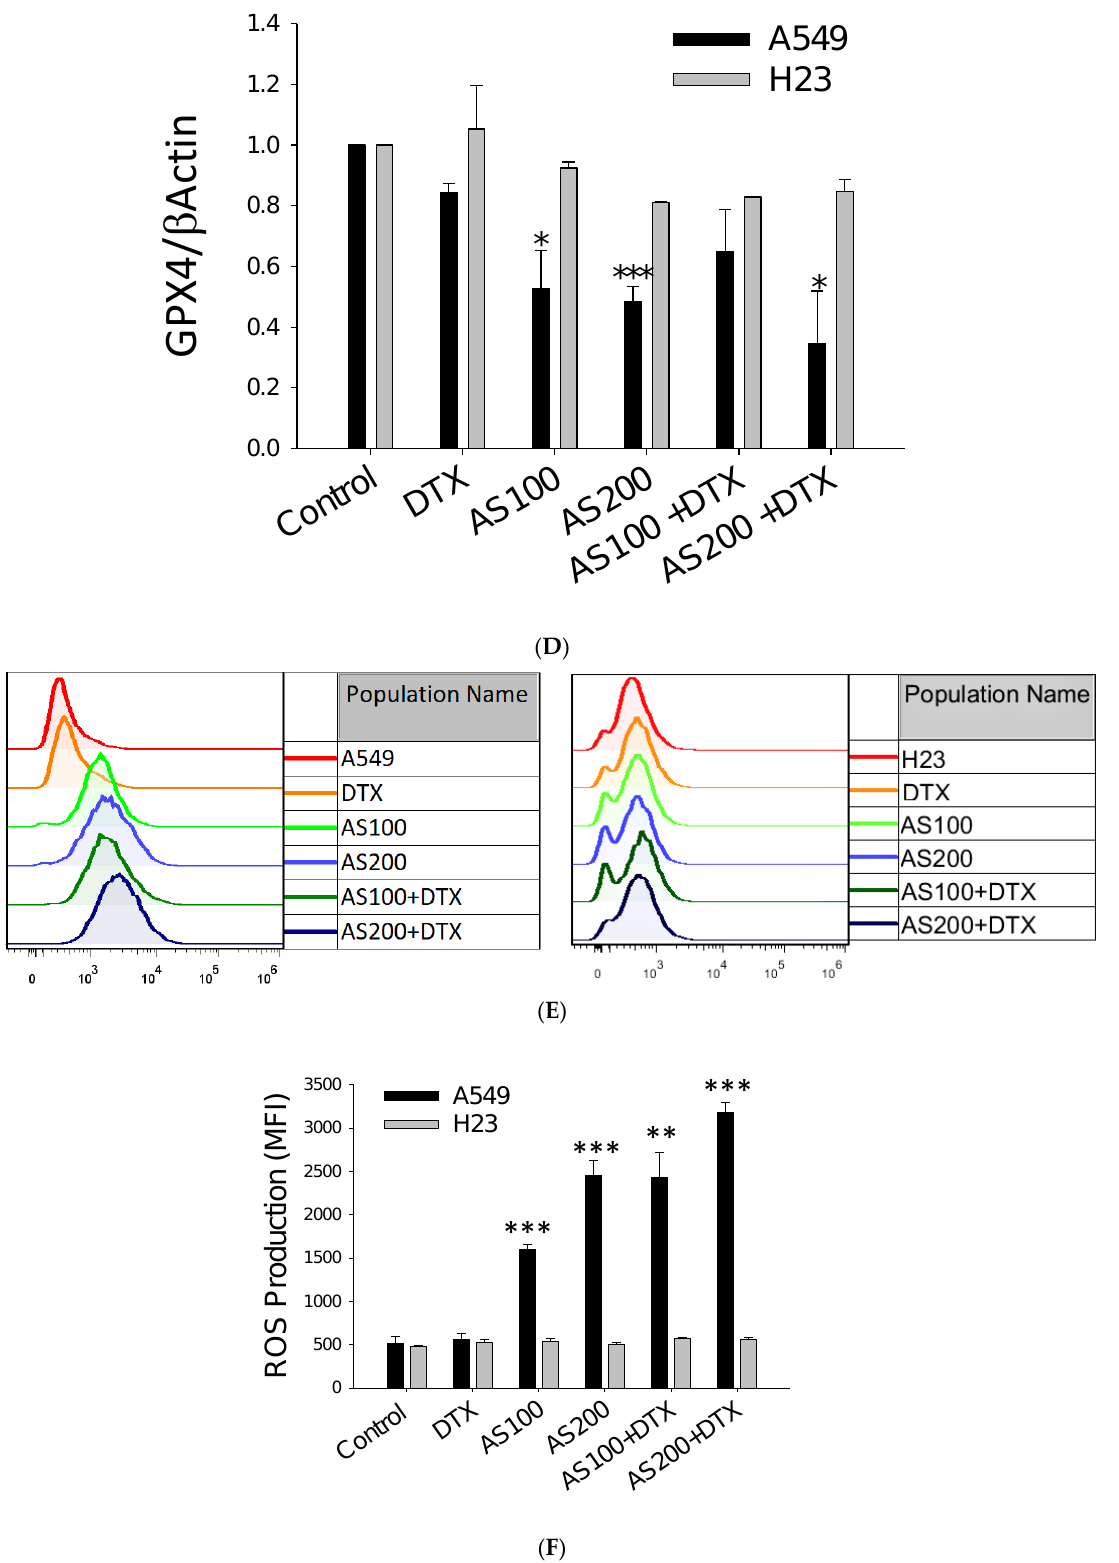
Figure 3. Apoptosis and ferroptosis contributed to AS-induced chemosensitization along with DTX in lung cancer cells: ( A ) the cells were treated with AS (100 and 200 µ g/mL) alone and/or in combination with DTX (0.5 nM) for 48 h. Western blot results of proteins with the most significant alterations of pro-caspase 3, cleaved caspase 3 levels in A549 and H23